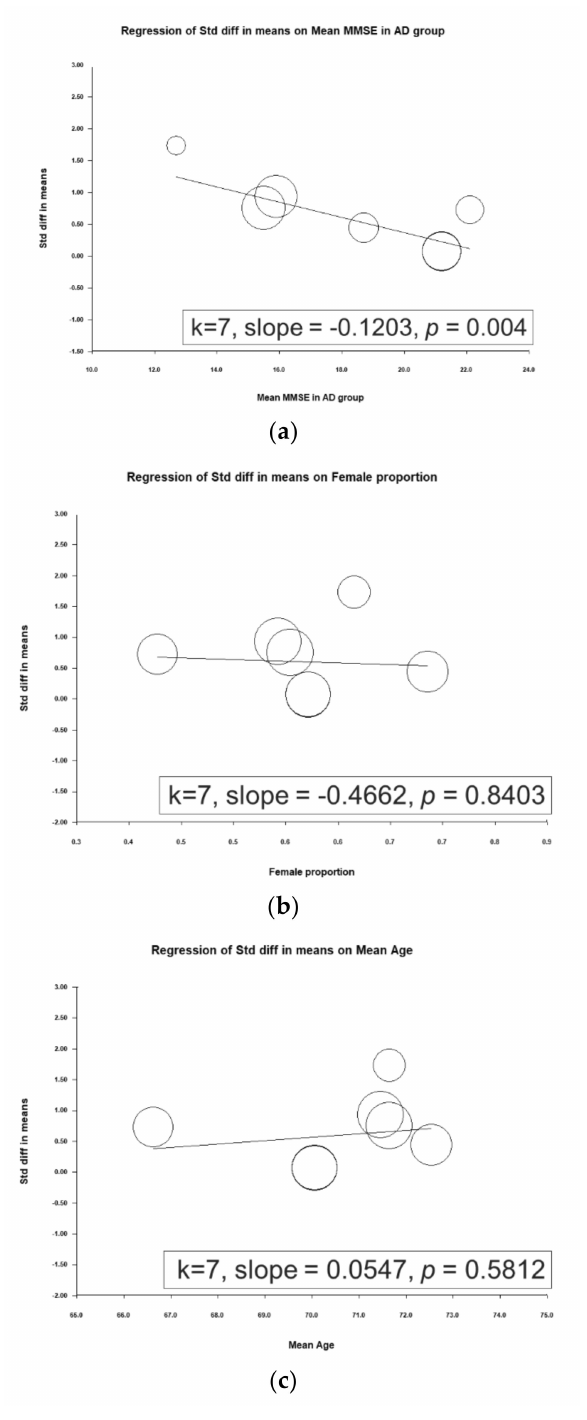
Figure 3. Meta-regression of the e ff ects of d -serine levels in relation to ( a ) mean mini-mental state examination(MMSE)scoreintheAlzheimer’sdiseasegroup, ( b )femalesexproportion, and( c )meanage. (Note: in the graph, each study is represented by a circle that shows the actual coordinates (observed e ff ect size by latitude) for that study. The size (specifically, the area) of each circle is proportional to that study’s weight in the analysis. k is the number of